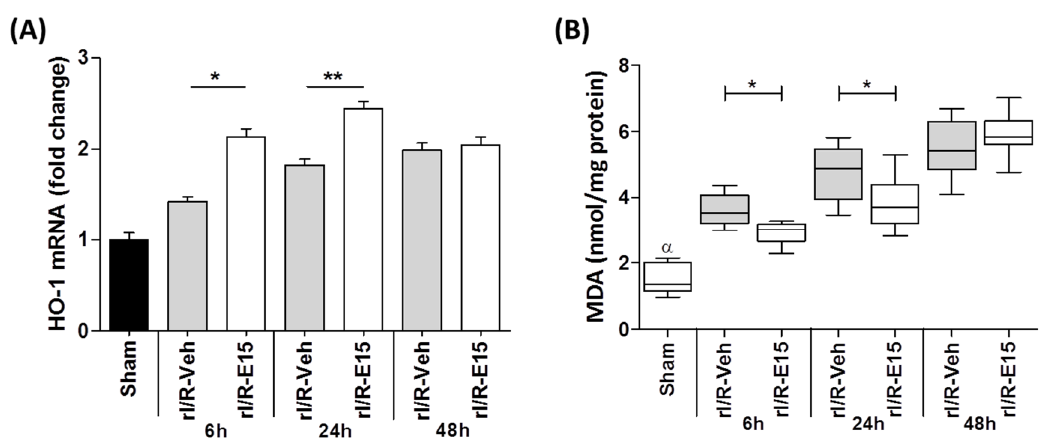
Figure 7. The E15 effect on Ho-1 expression and lipid peroxidation level after rI/R in the timeline (6, 24, and 48 h). ( A ) Shows the fold changes of Ho-1 mRNA quantified by qRT-PCR (mean ± SD) and ( B ) shows a Box-and-whisker plot (median, first-third quartile, minimum- maximum value) with MDA levels formation by TBARS assay. * p < 0.05, ** p < 0.01 compared to rI/R-veh. α p < 0.01 compared to rI/R-veh and rI/R-E15 groups, at 48 h.